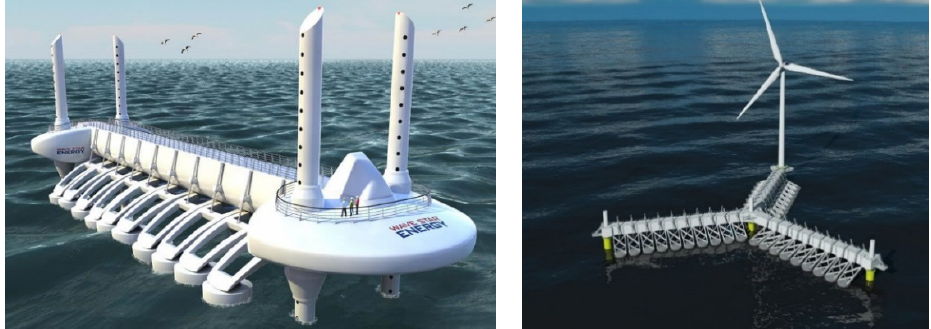
Figure 27. Rendering view of Wavestar [91,92].